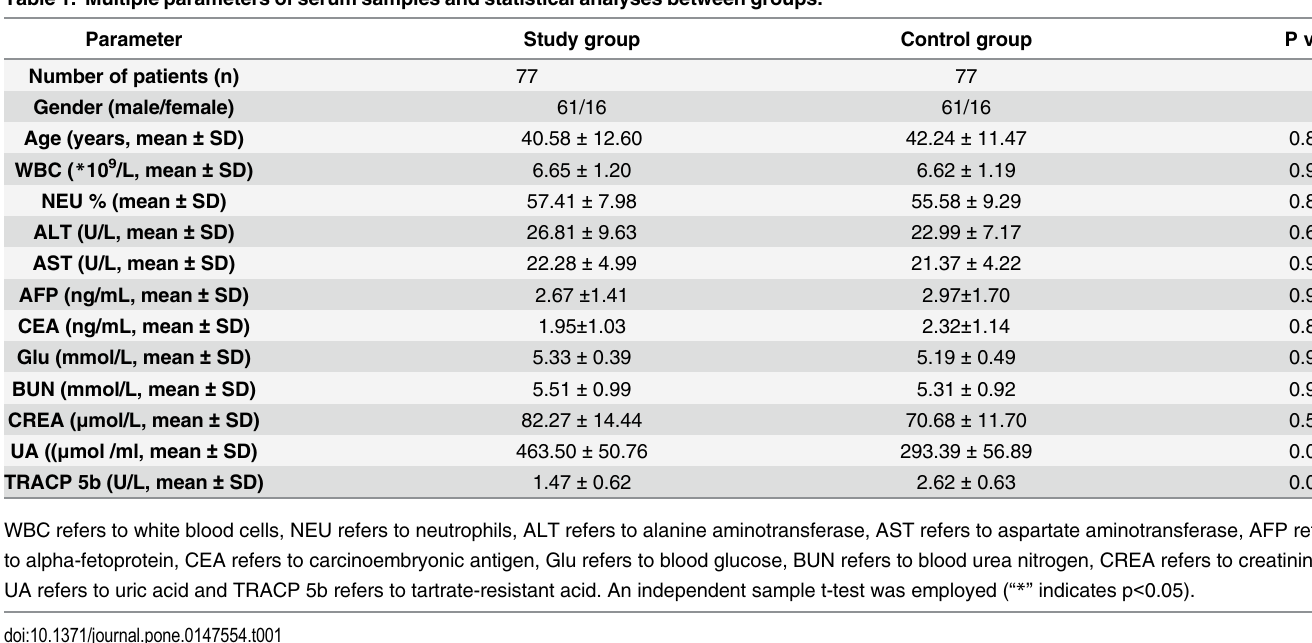
Table 1. Multiple parameters of serum samples and statistical analyses between groups.